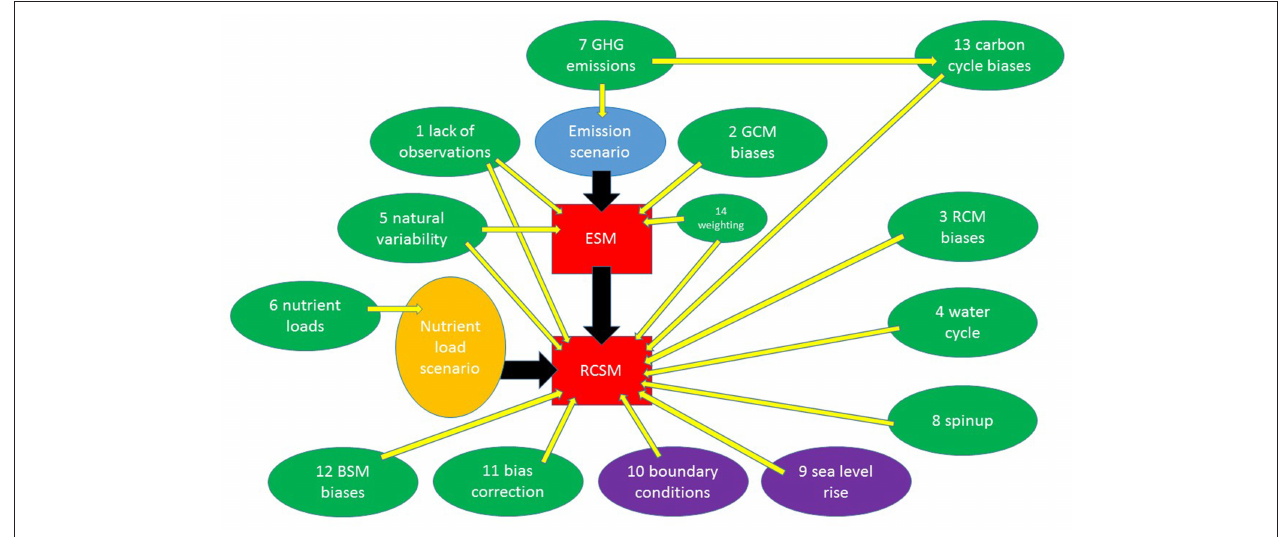
FIGURE 3 | Hierarchy of models in the dynamical downscaling approach as shown by Figure 2 and selected sources of uncertainties as discussed in the